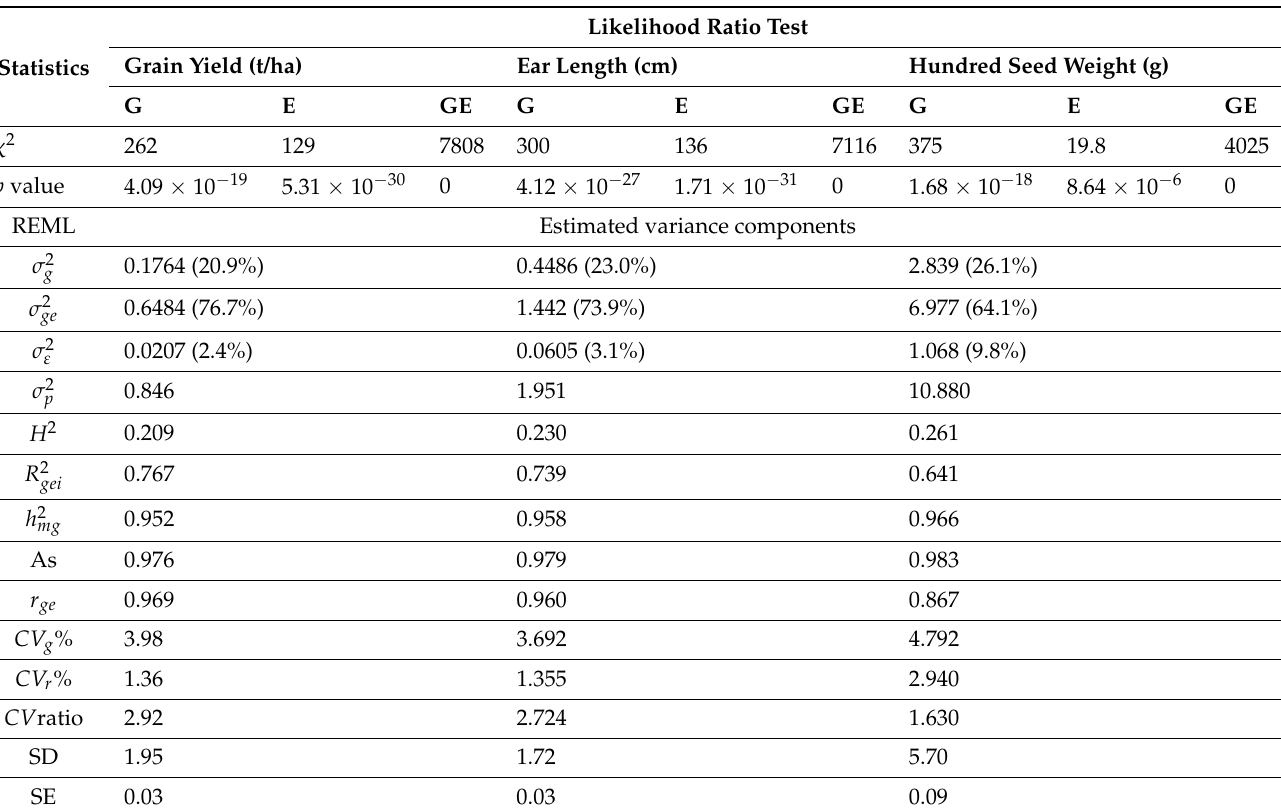
Table 1. Estimated variance components for three agronomic traits evaluated for 18 maize genotypes over 74